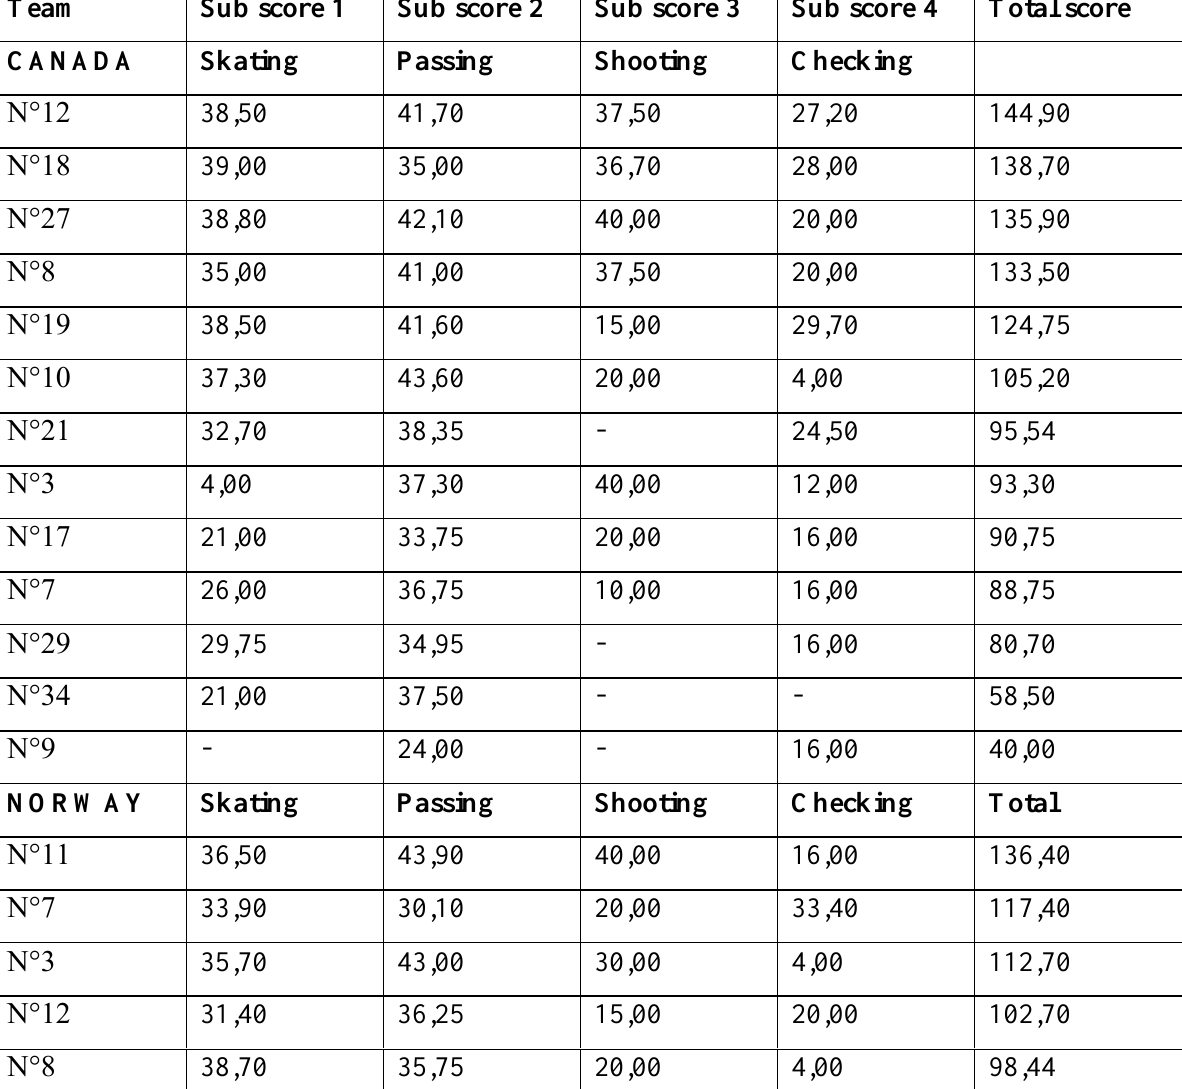
Score Sheets for Individual Players (listed in ranking order of Paralympic